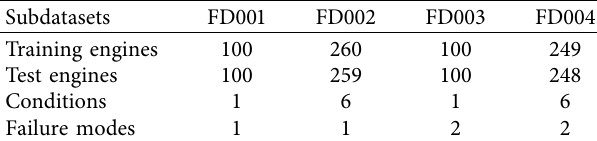
Table 1: C-MAPSS subdatasets. Table 2: The RMSE value of GAIN for different missing data